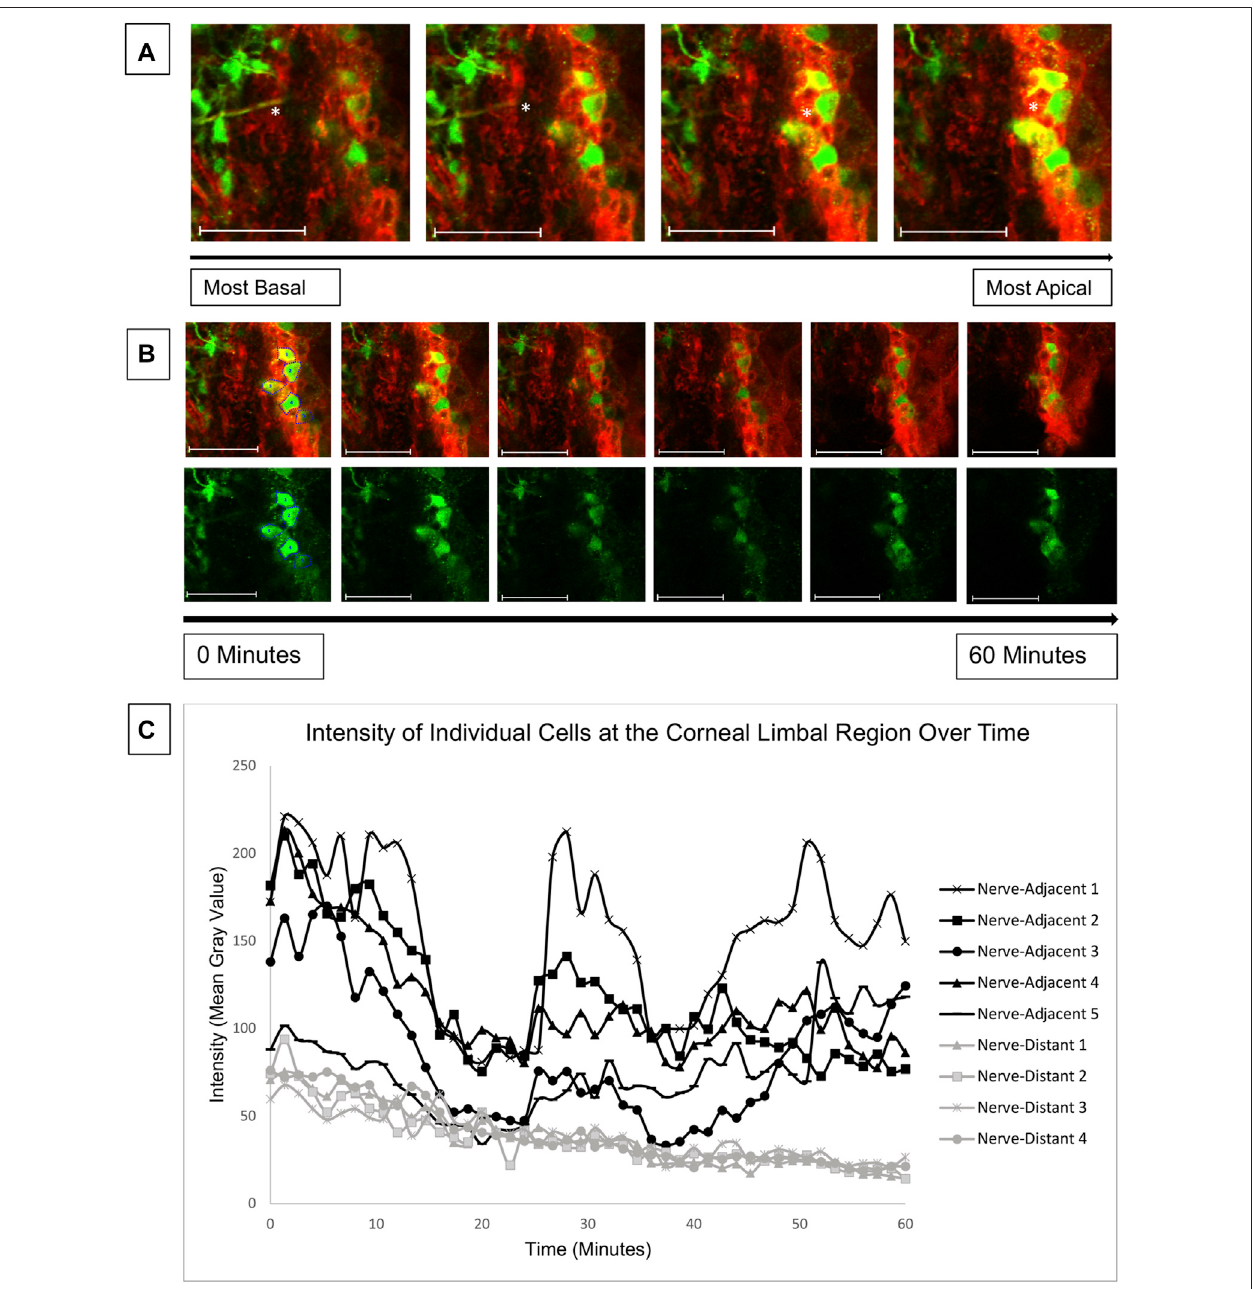
FIGURE 6 | Calcium mobilizations are detected in epithelial cells adjacent to nerves in the corneal limbal region. Enucleated globes from 9 to 13 week mice were stainedwithCellMaskDeepRed(red)membranestainandFluo-4,AM(green)calciumindicator,wounded,andimagedinthelimbalregionofthecorneafor1 husingthe Zeiss LSM 880 confocal microscope. Imaging started 15 min after injury ( T = 0). (A) Confocal imaging through the thickness of the corneal limbal region revealed high basalcellactivityadjacenttonerves(whiteasterisk). (B) Basalcellswereimagedovertimeatarateofoneframeper3 stoidentifycalciumsignalingevents.Thetop rowdepictstissuestainedwithCellMaskDeepRedandFluo-4forcellvisualization,andthebottomrowdepictsthesametissuewithFluo-4only. (C) Quanti fi cationofthe intensityofthecellslabelledin (B) overtimedemonstratesthatcellsadjacenttothenervedisplaydistinctsignalingeventsat0,25,and42 minafterimagingbegan.Atthe 25 and 42 min signaling events a previously inactive neighboring cell (Nerve-Adjacent 5) was activated. All cells denoted “ Nerve-Adjacent ” are within 100 microns of the nerve. The data represent fi ve eyes per condition, with each eye from one mouse. Scale bar is 50 microns.